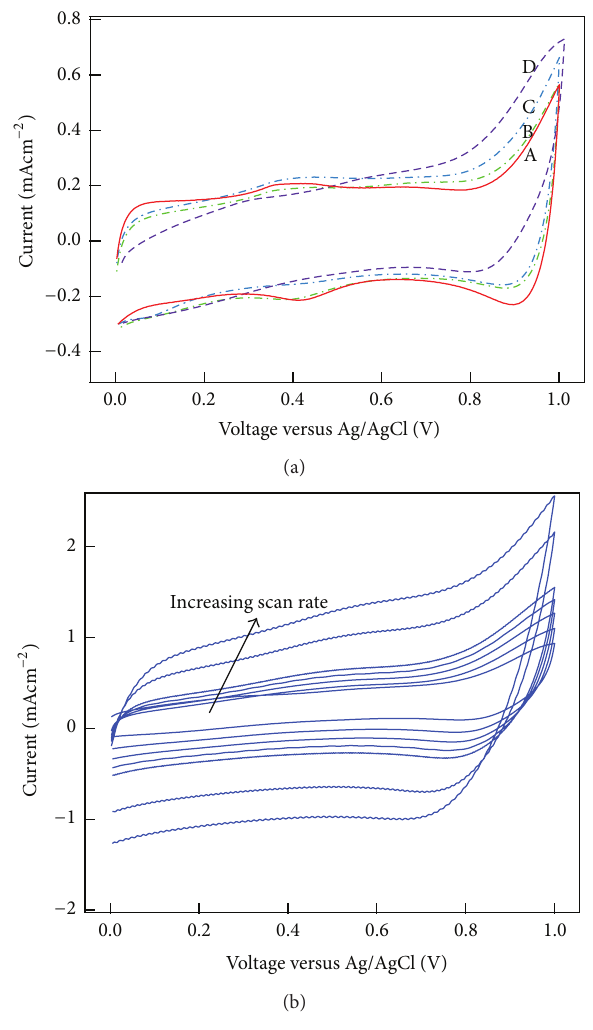
Figure 5: (a) Cyclic voltammograms obtained at a scan rate of 10mVs −1 for untreated MWCNTs/MnO 2 and wpCNTs/MnO 2 under different plasma conditions ((A): untreated, (B): 75W, 135Pa, (C): 140W, 135 Pa, (D): 10W, 135 Pa). (b) Cyclic voltammograms of